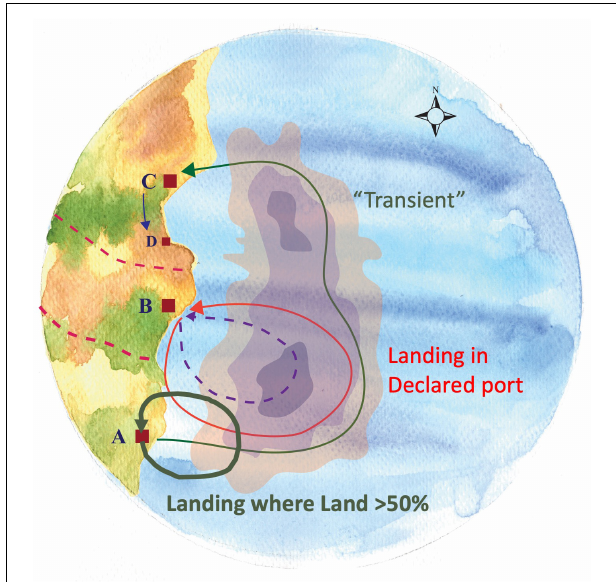
FIGURE 11 | Vessel’s association to port – Shifts in ports of landing. Different categories of vessels’ association to port may exist. A vessel can be registered in a certain port and declare it as its home port (“Declared”) (B) and concentrate there all of its activity (Arrow: Port B → B). A vessel can be associated simultaneously with more than one ports (e.g., A,C ). When the vast majority of trips ( > 50%) from a vessel based in port A, are landed therein, this is the vessel’s port of greater frequency (“Land > 50% Port”) (Thick arrow: Port A → A). However, for these few trips ( < 50%) of the vessel that commence in Port A but land in the distant port (C) , this vessel is characterized as “transient” (i.e., having neither type of association with Ports A,C ) (Thin arrow: Port A →